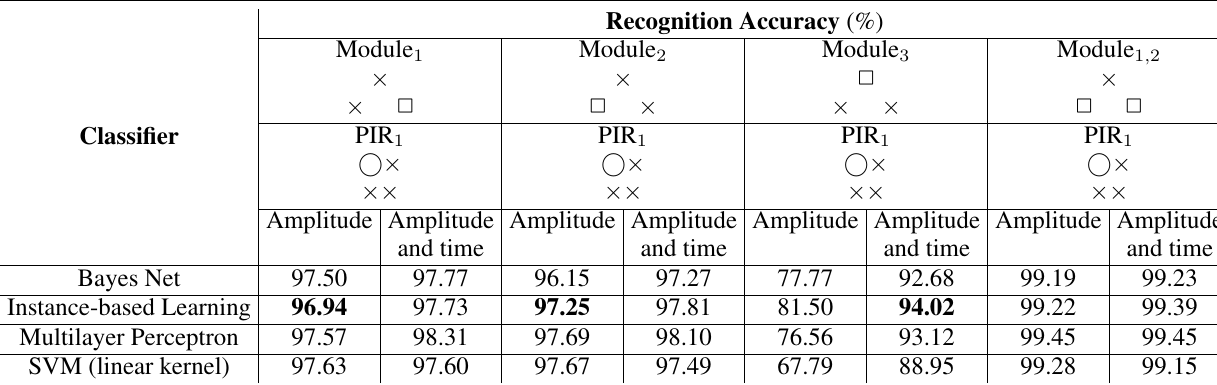
Table 9. Comparison of recognition accuracy (%) of classifying walking directions based on the reduced feature set with respect to the modules and features (amplitude and time to